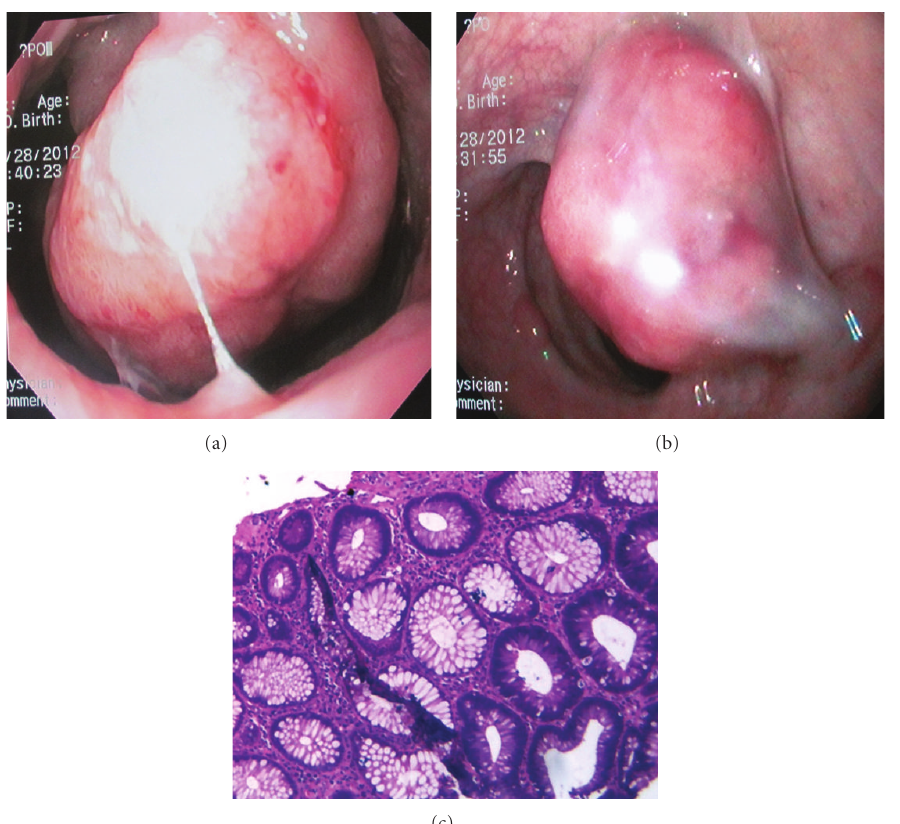
Figure 3: Colon endoscopy demonstrates tubulovillous adenomatous polyps, a sessile polyp 40 mm with adenomatous aspect in rectum (a) and in sigmoid colon (b).